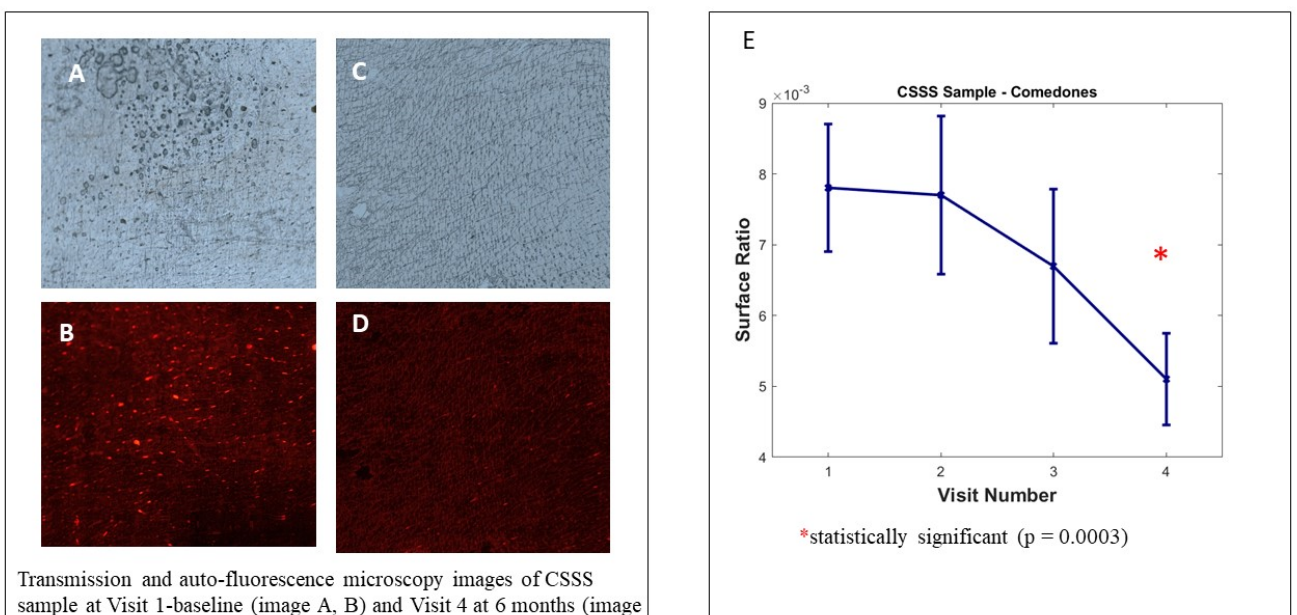
Figure 5. Cyanoacrylate superficial skin surface (CSSS) biopsy analysis. Transmission and auto-fluorescence microscopy images of CSSS sample at Visit 1 baseline (image A , B ) and Visit 4 at 6 months (image C , D ) (Subject P0403). Image ( E ) Sample analysed with Mixed Model for Repeated Measures (MMRM), using visit and country as fixed factor and subject as random factor.